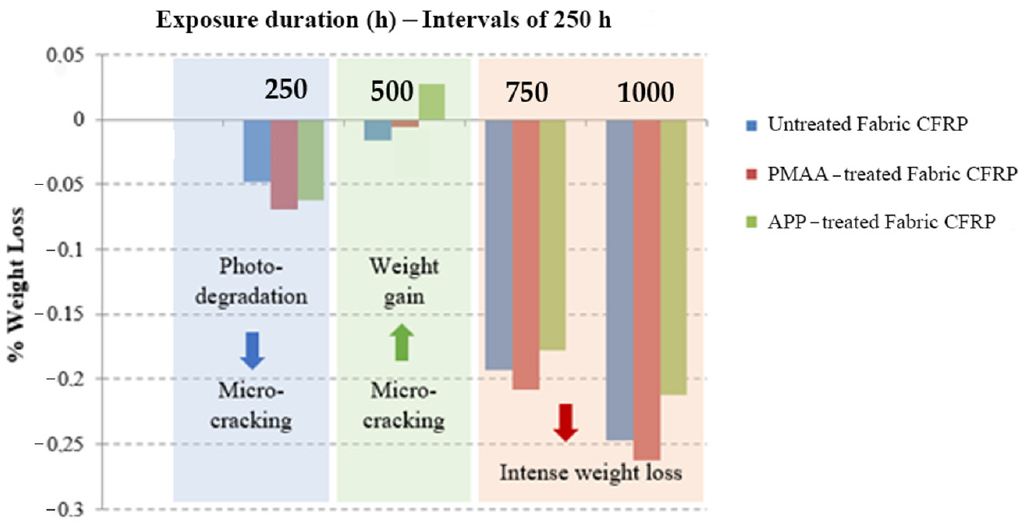
Figure 2. Weight loss data collected for 1000 h QUV.